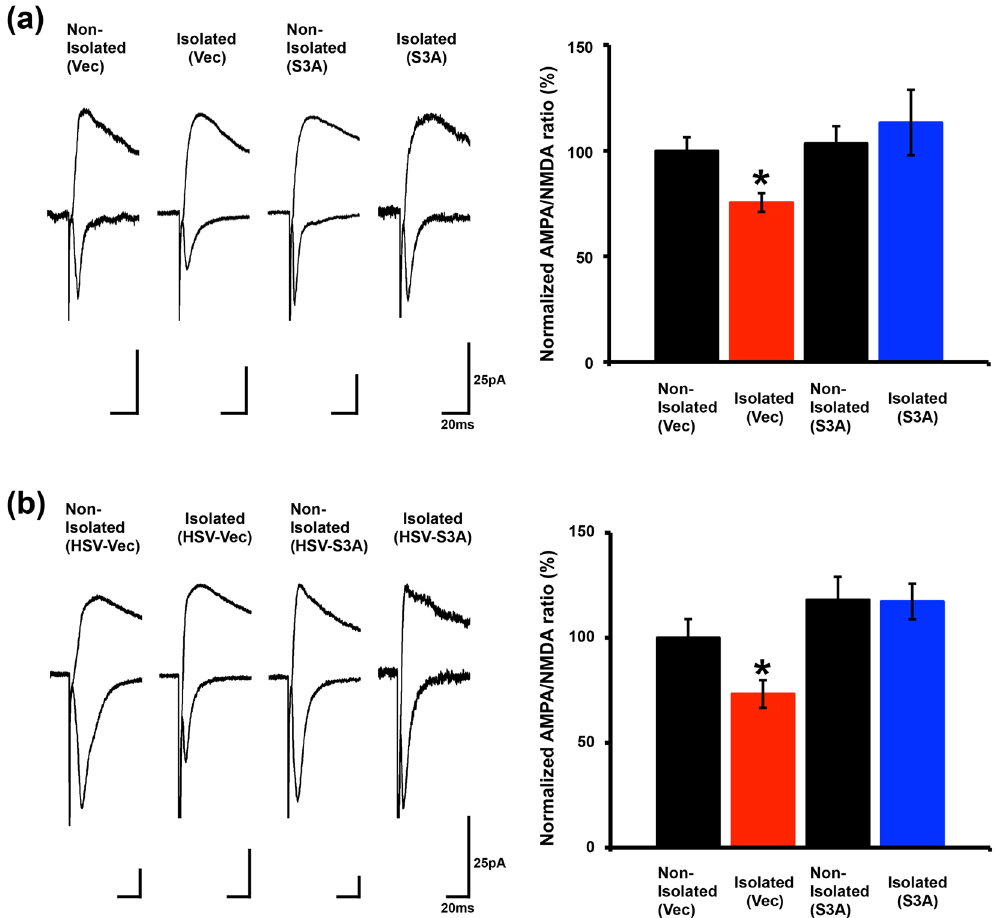
Figure 3. Expression of the constitutively active ADF/cofilin phospho-mutant (S3A) leads to the recovery of experience-driven synaptic AMPA receptor delivery in the barrel cortex of socially isolated rats. ( a ) Representative traces of neurons expressing RFP-S3A or RFP (control) in isolated or non-isolated rats. Scale bars 25 pA, 20 ms. Social isolation decreased the AMPA/NMDA ratio in neurons expressing RFP (isolated, n = 16; non-isolated, n = 23). The reduced AMPA/NMDA ratio was prevented in neurons expressing RFP- S3A (isolated, n = 15; non-isolated, n = 20). * P < 0.05 (ANOVA, F (3,70) = 2.877). Error bars represent SEM. ( b ) Representative traces of neurons expressing HSV-S3A-IRES-Venus or HSV-IRES-Venus (control) from isolated or non-isolated rats. Scale bars 25 pA, 20 ms. S3A was expressed after the isolation period. Social isolation decreased the AMPA/NMDA ratio in neurons expressing HSV-IRES-Venus (isolated, n = 7; non-isolated, n = 11). The reduced AMPA/NMDA ratio was rescued in the neurons expressing HSV-S3A-IRES-Venus (isolated, n = 5; non-isolated, n = 6). * P < 0.05 (ANOVA, F (3,25) = 4.550). Error bars represent